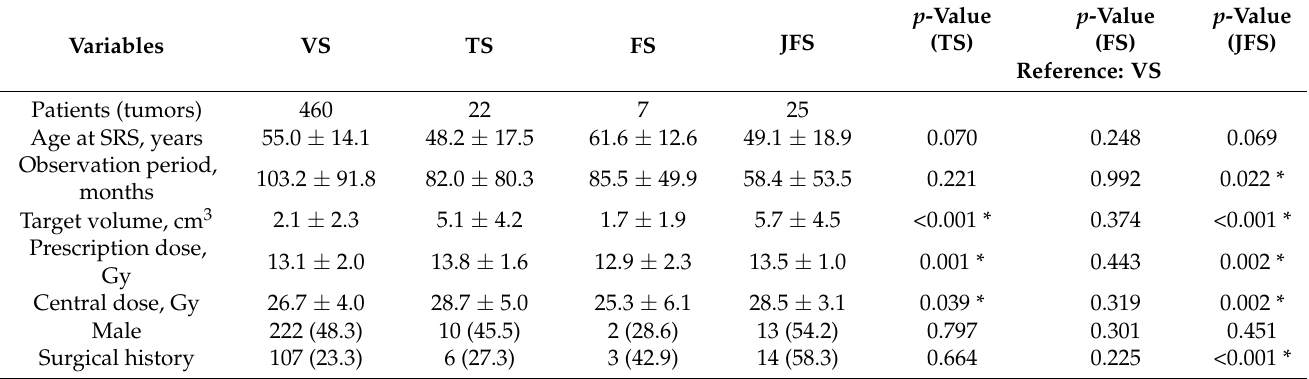
Table 1. Baseline characteristics and dosimetry data of the entire cohort before